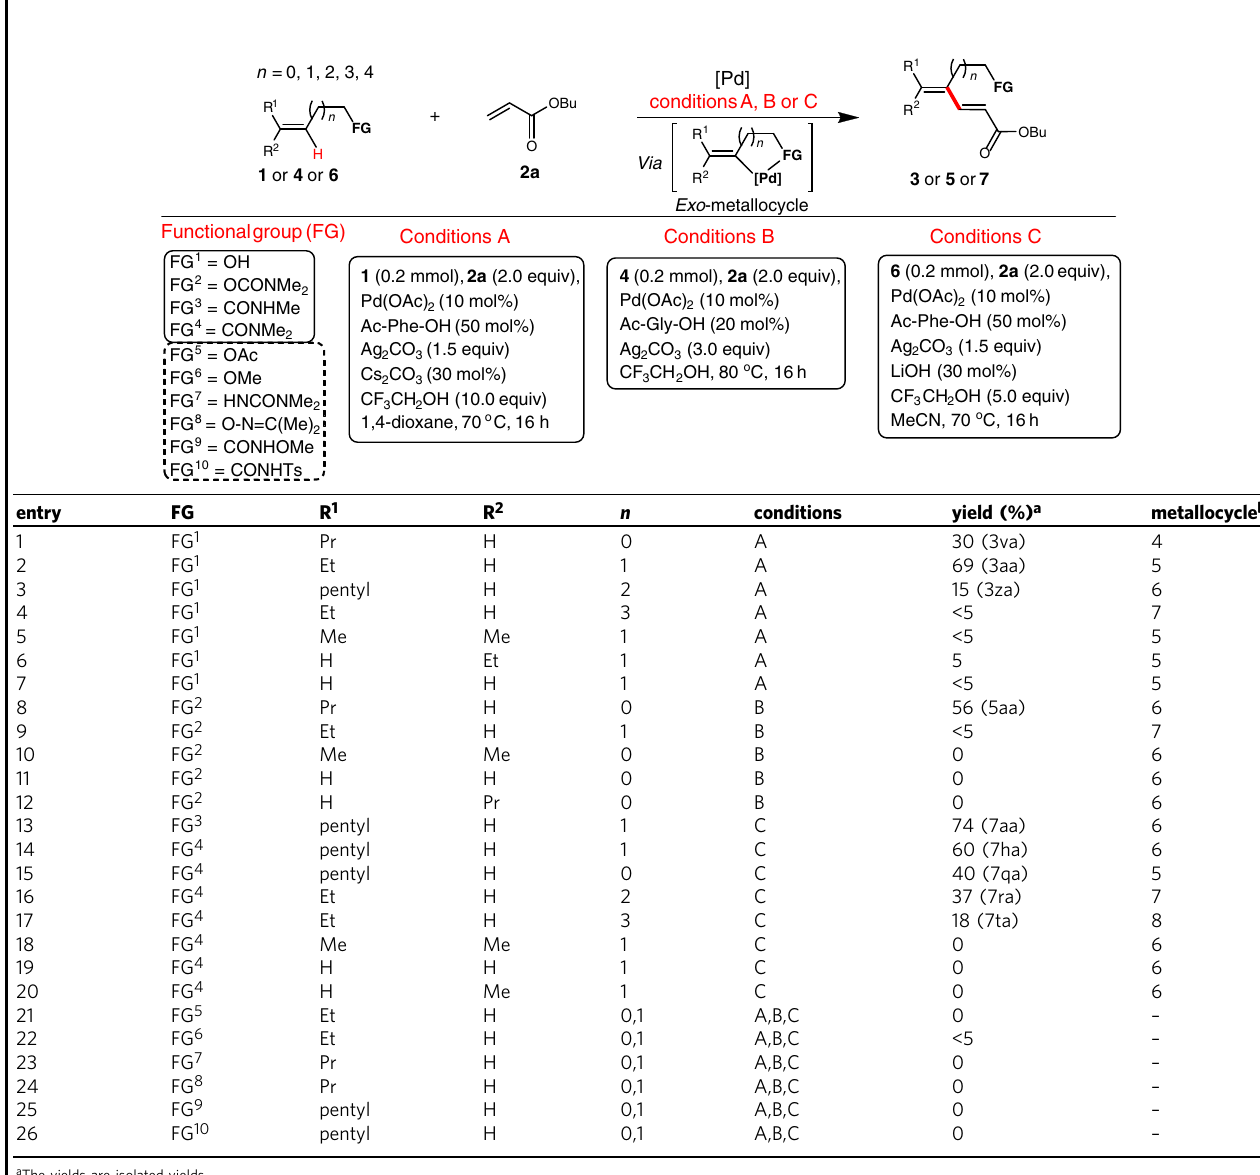
Table 1 Development of gem -group-directed ole fi nic C – H